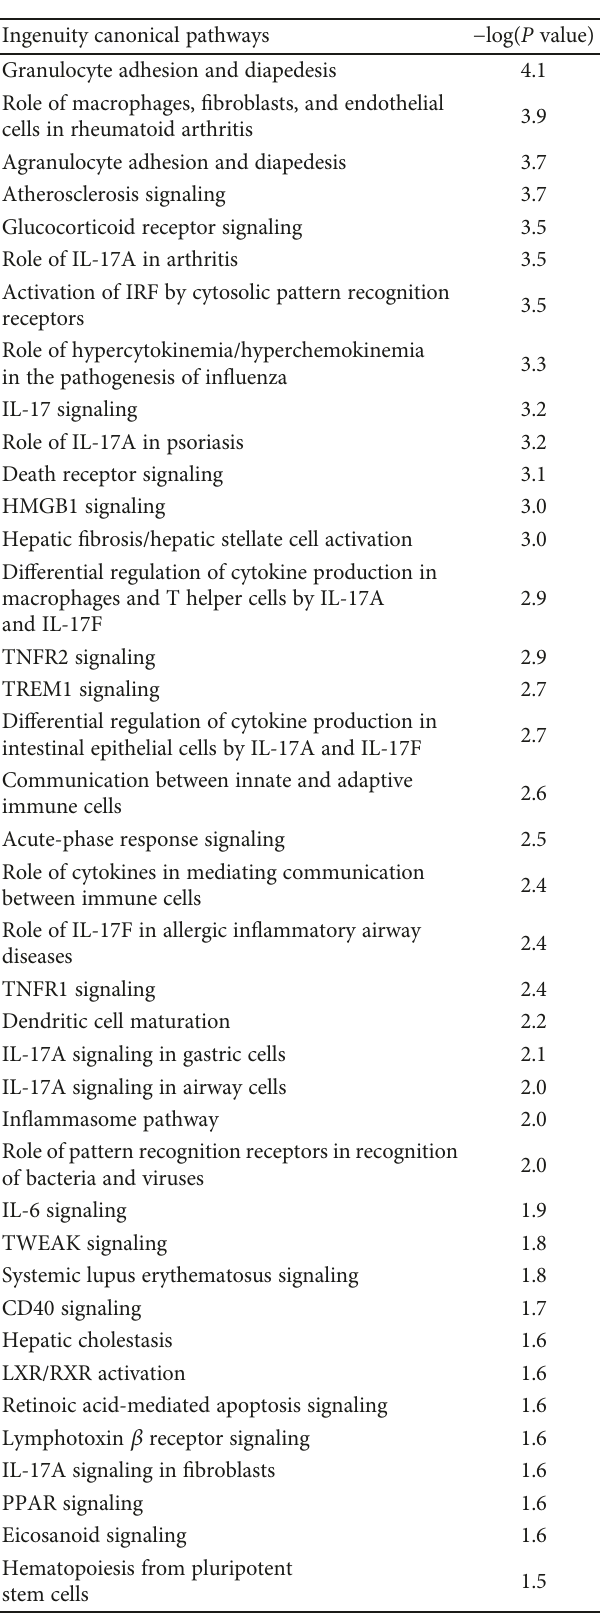
Table 4: Signi fi cant canonical pathways identi fi ed by Ingenuity Pathway Analysis (IPA) in HMECs after 3 h treatment with